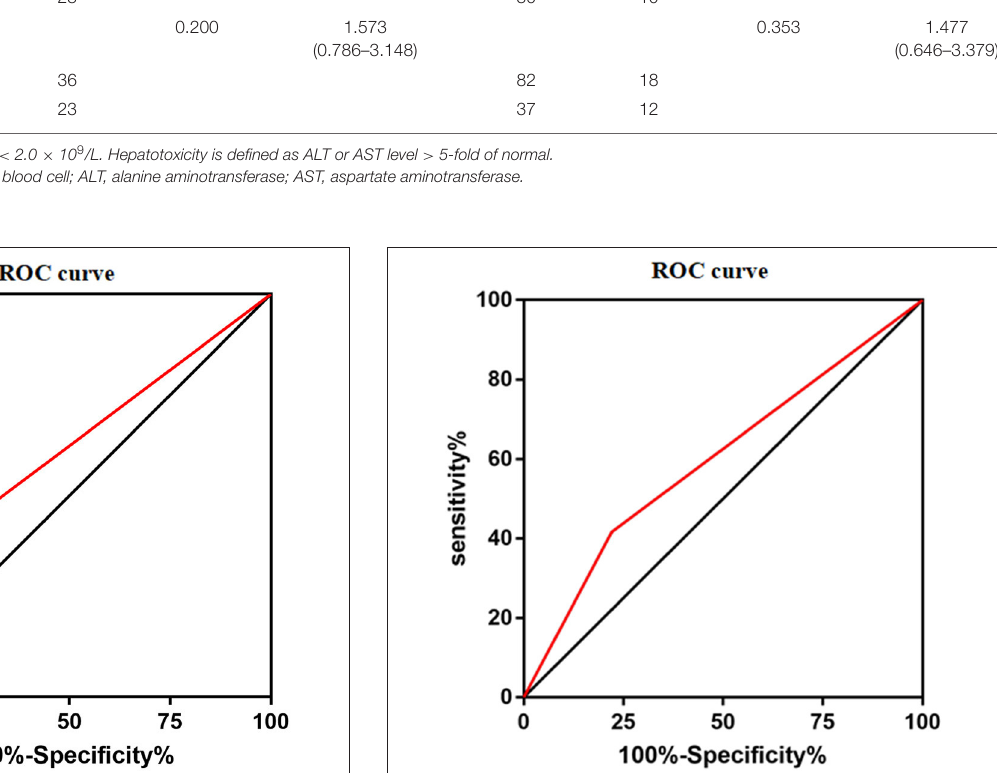
6-MP tolerable dose decrease, p = 0.021, OR = 2.514 (95%